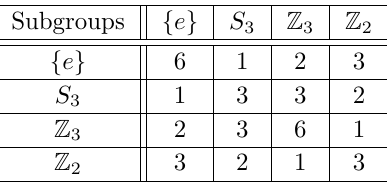
Table 6 . The GSDs of the extended QD model with G = S 3 on a cylinder, whose two boundaries are speci(cid:12)ed by two subgroups of S 3 .